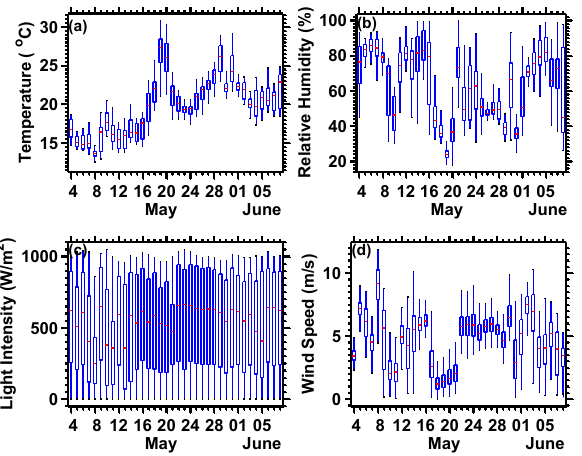
Fig. 5. Average diurnal variation in: (a) ambient temperature: (b) relative humidity, (c) light intensity, and (d) wind speed. Time of day corresponds to local standard time